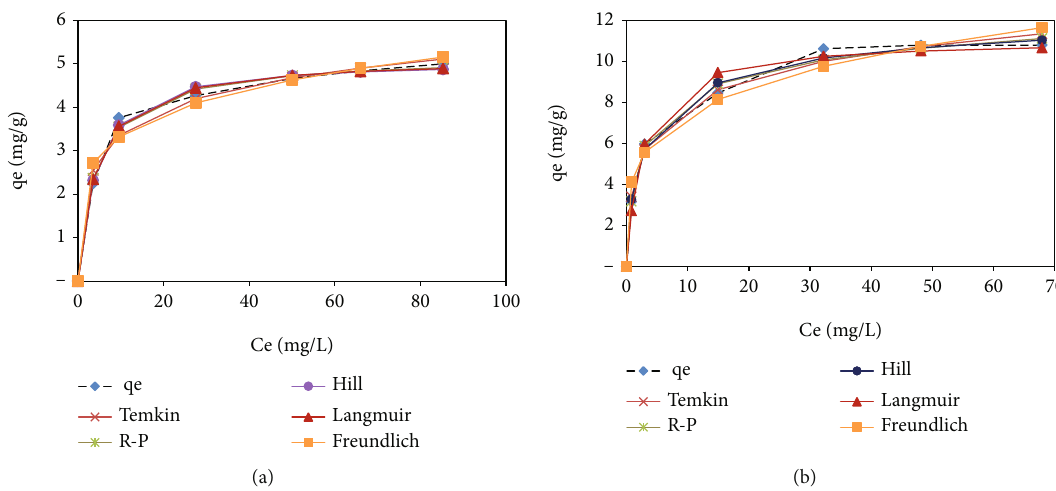
Figure 14: Behavior of the Langmuir, Freundlich, Hill, Rendlich-Peterson and Temkin adsorption isotherm models with respect to the experimental data: (a) untreated rice husk and (b) treated rice husk. (pH =7, rice husk size S2: < 425 - 600 μ m > and 150mg of biosorbent). Table 6: Comparison of maximum adsorption capacity of other adsorbents with chemically modi fi ed rice husk.